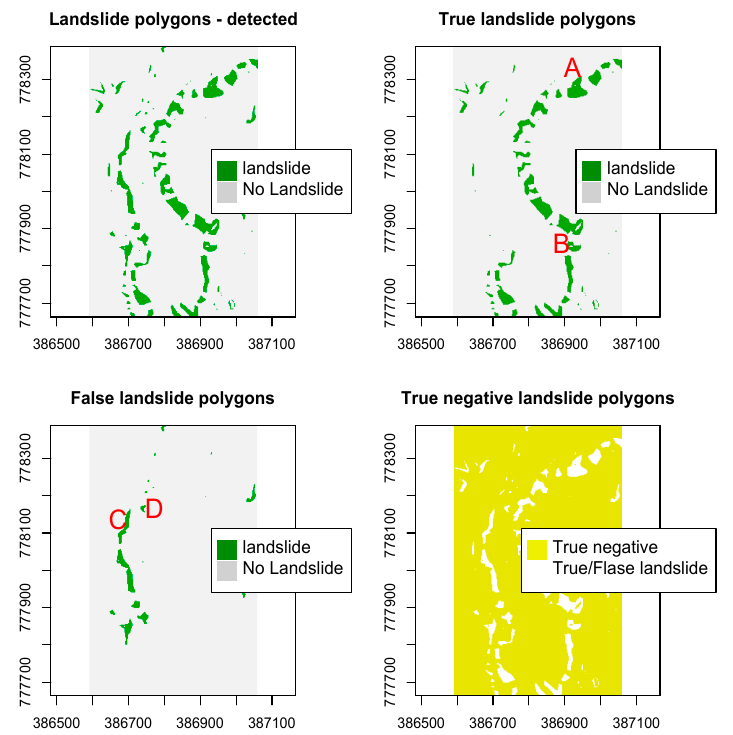
Figure 6. Over 84% of the polygons detected as landslides by the proposed tool ( A ) fell in zones presenting real signs of landslides within the study site; ( B ) The remaining 16% of the polygons did not belong to zones with active landslides; ( C ) Most of study site’s surface is not subjected to landslides, being the proposed tool effective in classifying these areas as “true” negative landslide polygons ( D ). The labeled polygons ( A ), ( B ), ( C ), and ( D ) are shown in Figure